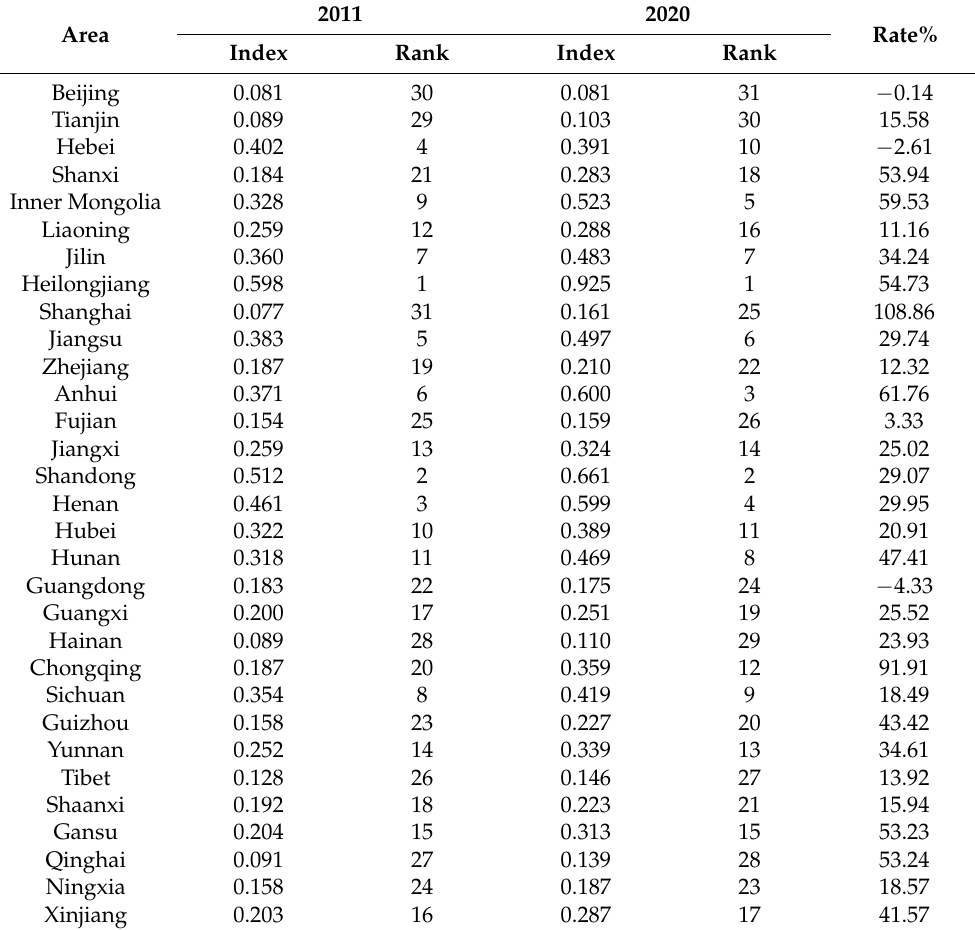
Table 6. Food security and ranking of provinces in China.